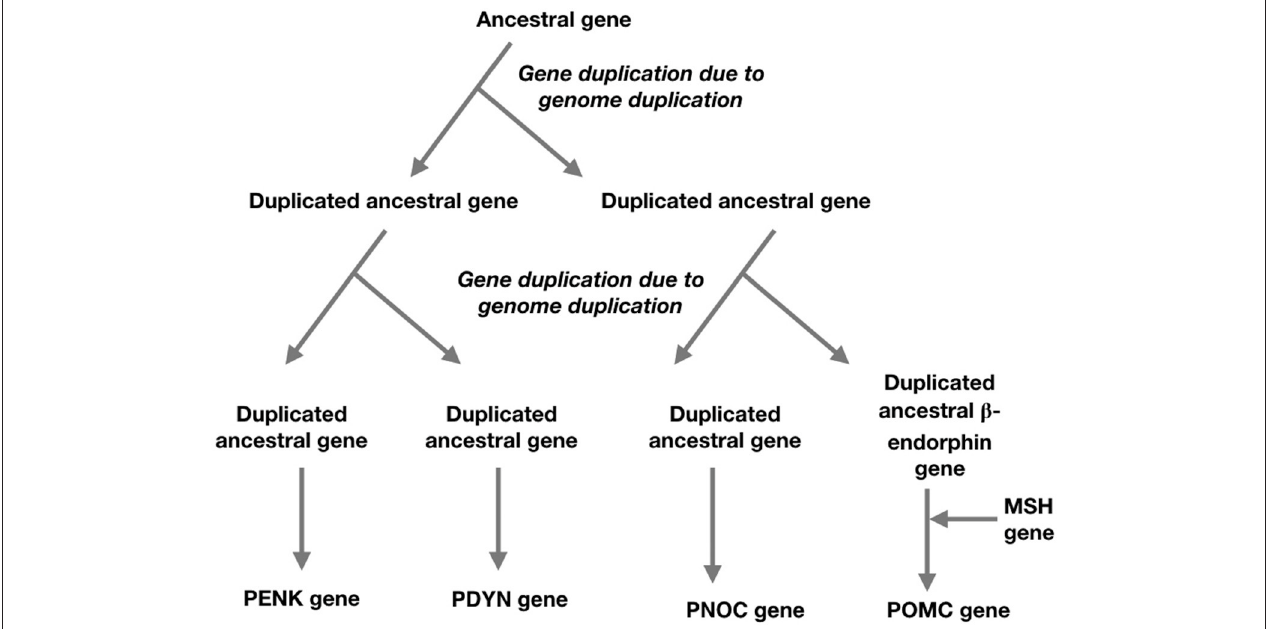
FIGURE 2 | A schema for the evolution of the opioid/orphanin gene family based on two genome duplications and the insertion of melanocortin sequence to ancestral beta-endorphin gene (based on Sundström et al., 2010; Navarro et al., 2016).